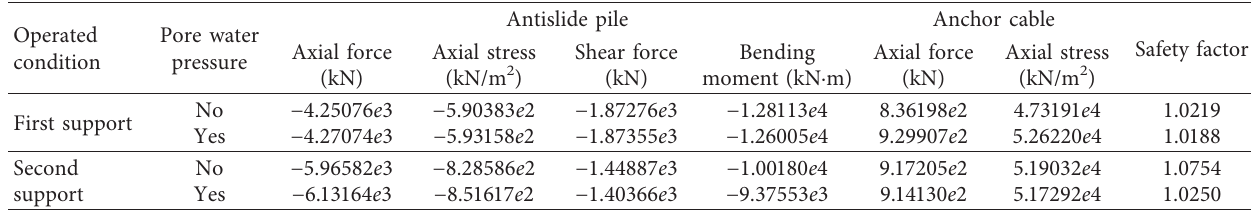
Figure 16: Cloud diagrams of prestressed anchor cable considering steady-state seepage: (a) axial force; (b) axial stress. Table 5: Extreme value of each operating